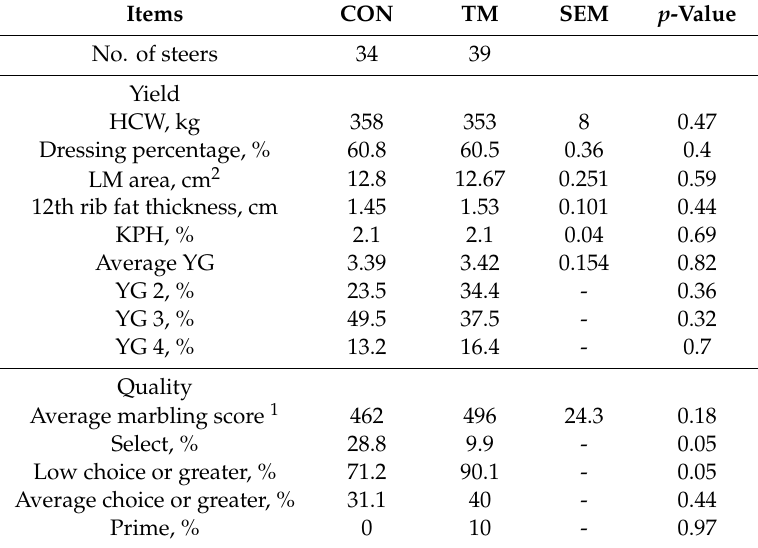
Table 5. E ff ects of maternal supplementation of trace minerals on carcass characteristics of subsequent steer progeny. Items CON TM SEM p -Value